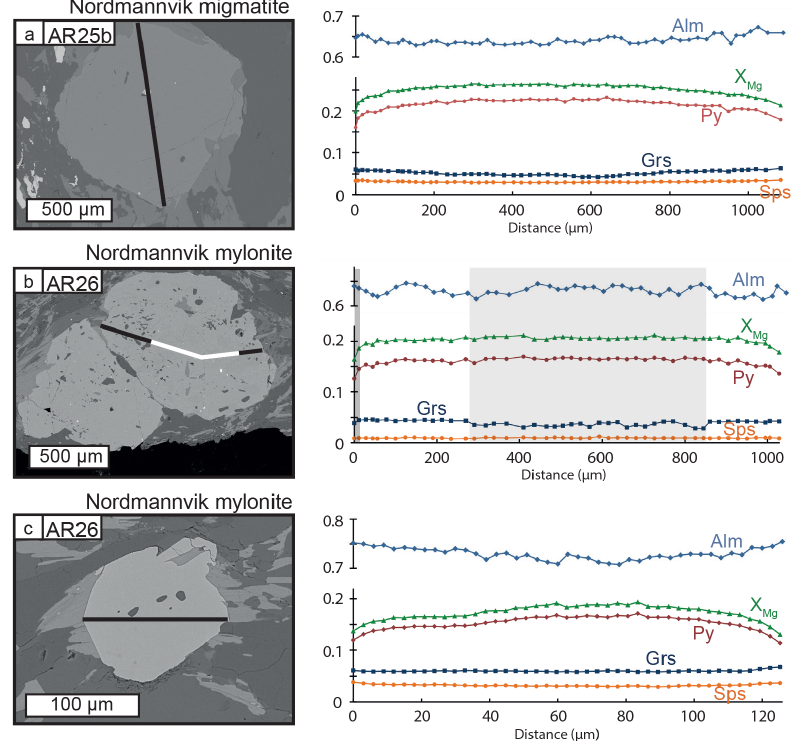
Figure 9. BSE images and garnet profiles for Nordmannvik Nappe samples AR25b and AR26. (a) Garnet in AR25b displays a profile with a steady increase in Alm, Grs, and Sps contents and decrease in Py and X Mg towards garnet rims. (b) The garnet profile for the large garnet in sample AR26 displays a relatively flat profile with some compositional change towards the rims. An inclusion-free core, marked in grey on the profile and in white on the BSE image, shows slightly lower and more variable Grs content. (c) The garnet profile for small garnets in sample AR26 shows a steady increase in Alm, Grs, and Sps contents and steady decrease in Py and X Mg contents towards the